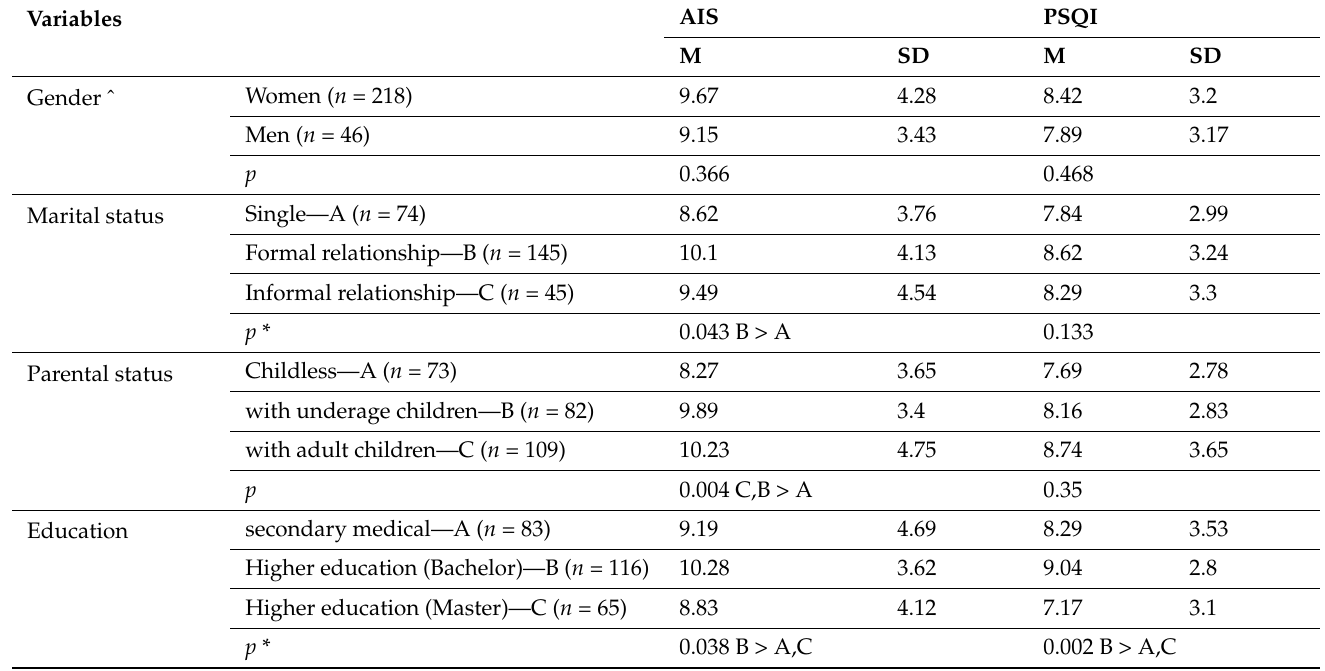
Table 4. The influence of selected sociodemographic variables on sleep